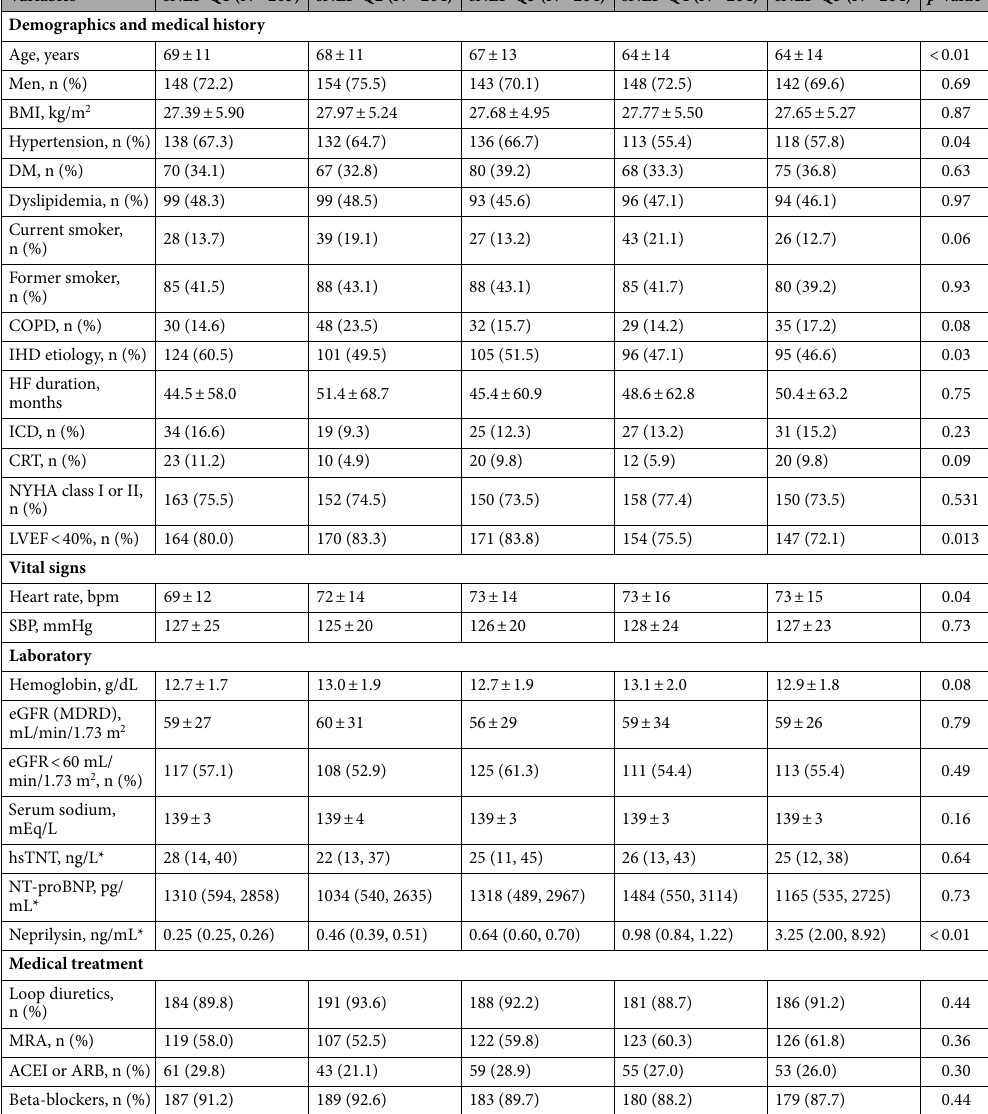
Table 2. Baseline characteristics across sNEP quintiles. Continuous variables are expressed as mean ± 1 standard deviation unless otherwise specified. ACEI angiotensin-converting enzyme inhibitors, ARB angiotensin II receptor blockers, BMI body mass index, COPD chronic obstructive pulmonary disease, CRT cardiac resynchronization therapy, DM diabetes mellitus, eGFR estimated glomerular filtration rate, HF heart failure, ICD implantable cardioverter-defibrillator, LVEF left ventricle ejection fraction, MDRD Modification of Diet in Renal Disease formula, MRA mineralocorticoid receptor antagonist, NT-proBNP amino-terminal pro- brain natriuretic peptide, NYHA New York Heart Association, SBP systolic blood pressure, sNEP soluble form of neprilysin. *Variable expressed as median (interquartile